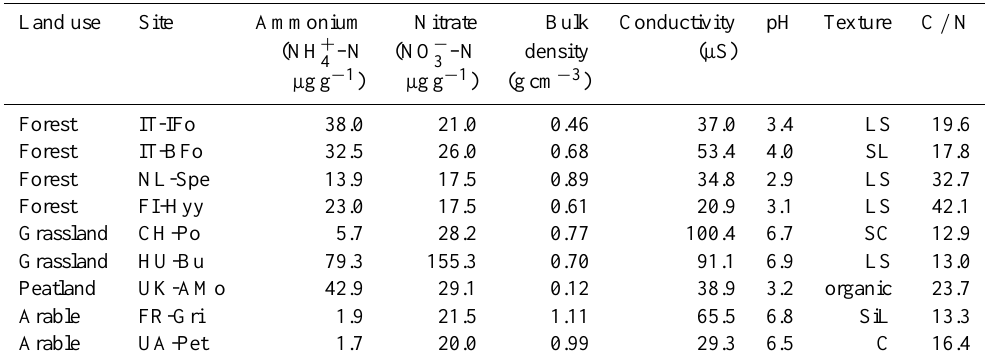
Table 2. Soil characteristics of the nine sampling sites. Indicated soil textures are loamy sand (LS), sandy loam (SL), sandy clay (SC), silt loam (SiL), and clay